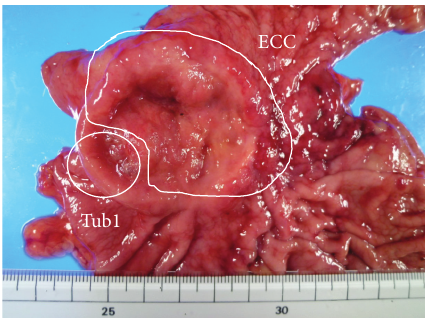
Figure 3: Distal gastrectomy with D2 lymph node dissection and Billroth I reconstruction was performed. Pathological examination revealed that adenocarcinoma cells comprised < 10% of all cancer